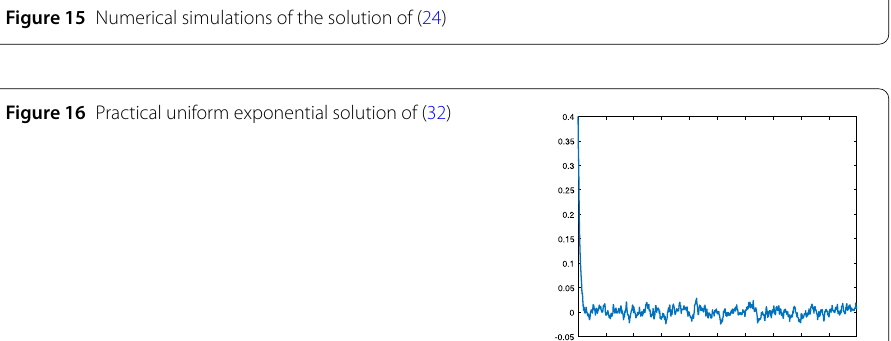
Figure 15 Numerical simulations of the solution of (24)